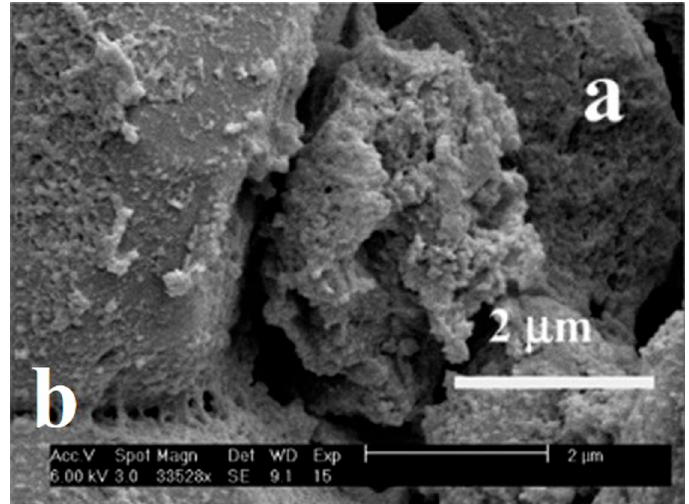
Figure 9. SEM image of a biocalcareous stone treated with an organic-inorganic hybrid (obtained by co-condensation of TEOS and polydimethylsiloxane): ( a ) coating on the stone grains; ( b ) nano-material bridges linking together the grains of the stone. Adapted with permission from [54]. Copyright 2010 American Chemical Society.